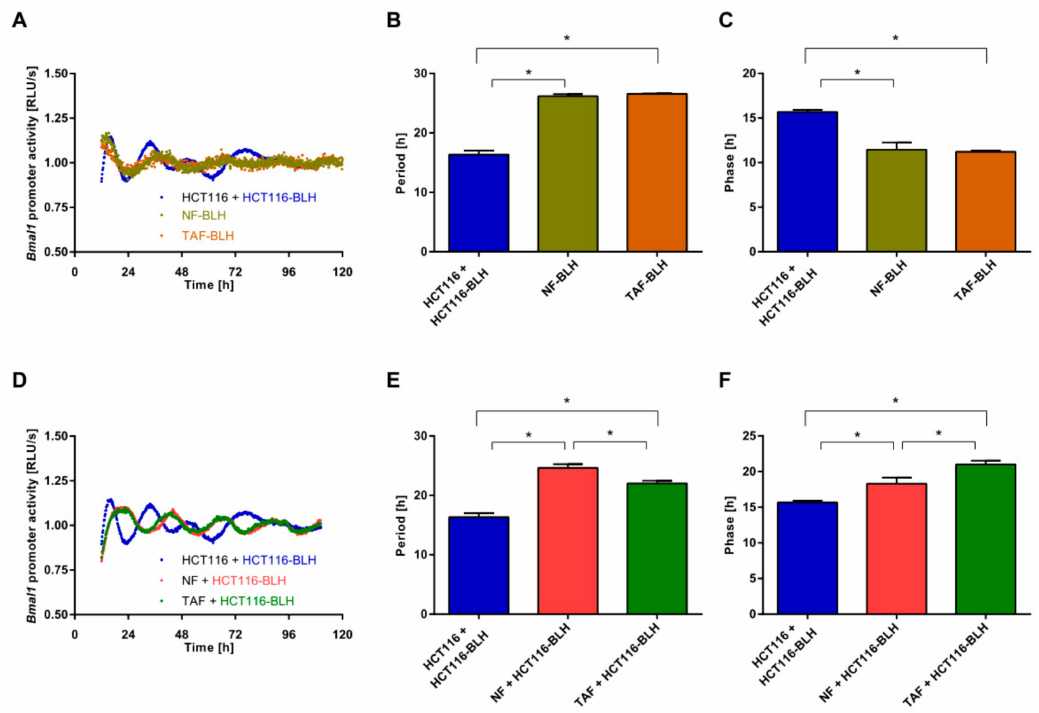
Figure 3. Cell-to-cell communication impacts the circadian phenotype. ( A ) HCT116, normal fibroblast (NF),andtumour-associatedfibroblast(TAF)cellswerelentivirallytransducedandthe BMAL1 -promoter activity was measured over five consecutive days. Shown is one representative replicate per